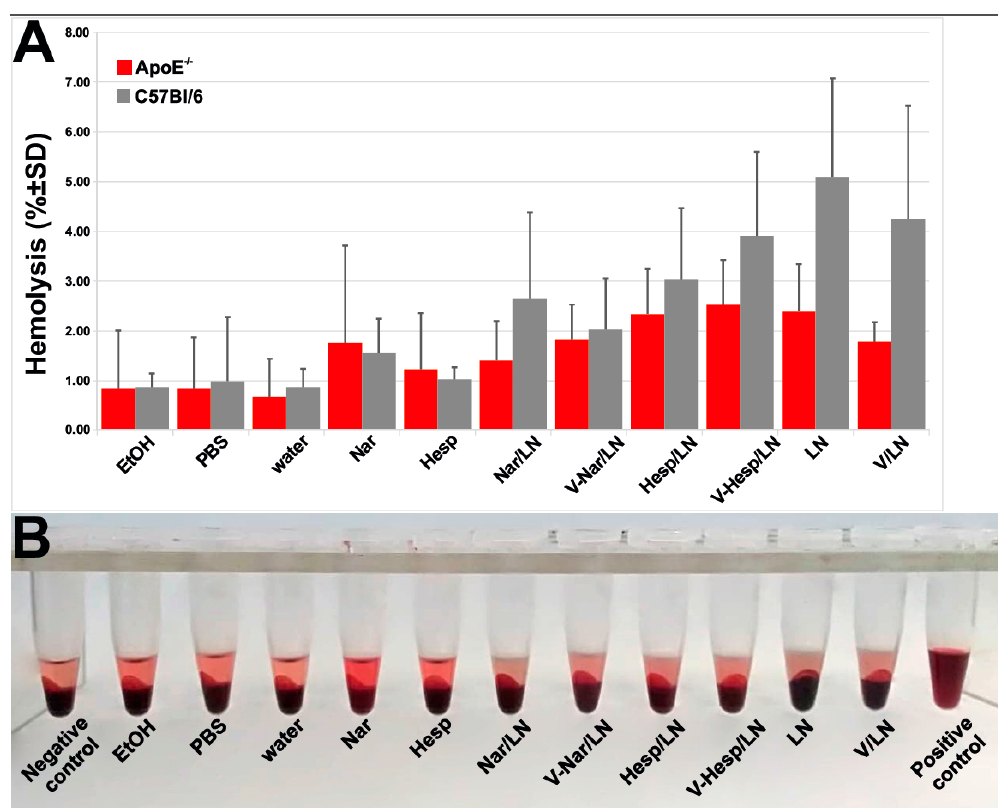
Figure 7. Flavonoid-loaded nanoemulsions did not cause lysis of erythrocytes from apoE-deficient or C57 Black mice. ( A ) Quantification of hemolysis by measuring the absorbance at 540 nm. ( B ) Photographs of the pelleted erythrocytes upon exposure to various experimental conditions.